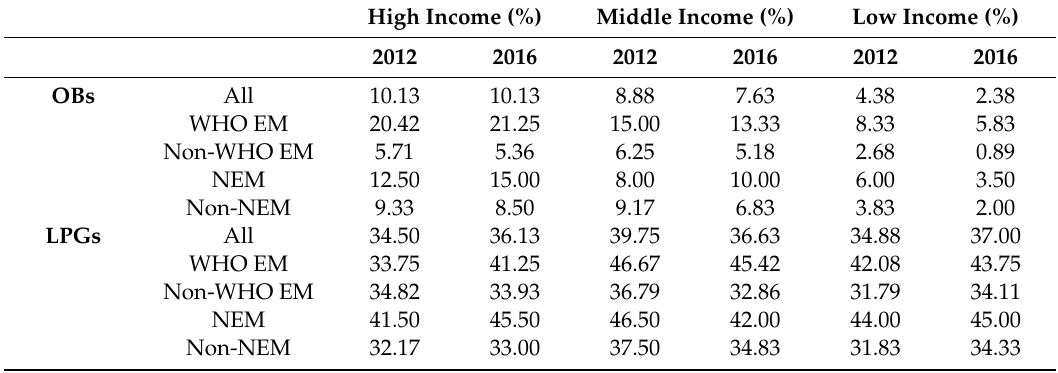
Table 5. Mean availability of anticancer medicines in the Jiangsu Province: inter-region